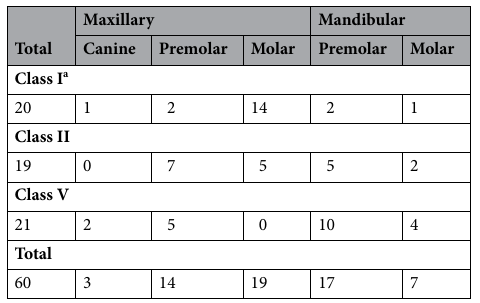
Table 1. Distribution of the self-adhesive bulk-fill restorations at baseline (n = 60). a Occlusal surface of premolars and molars, lingual surface of canine.